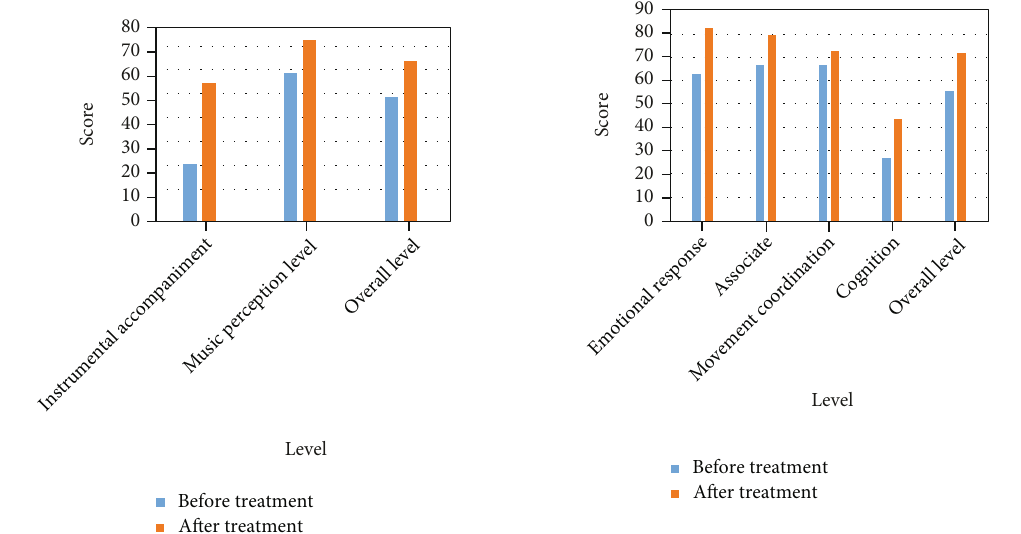
Figure 8: The emotional and behavioral performance of Xiao F before and after music